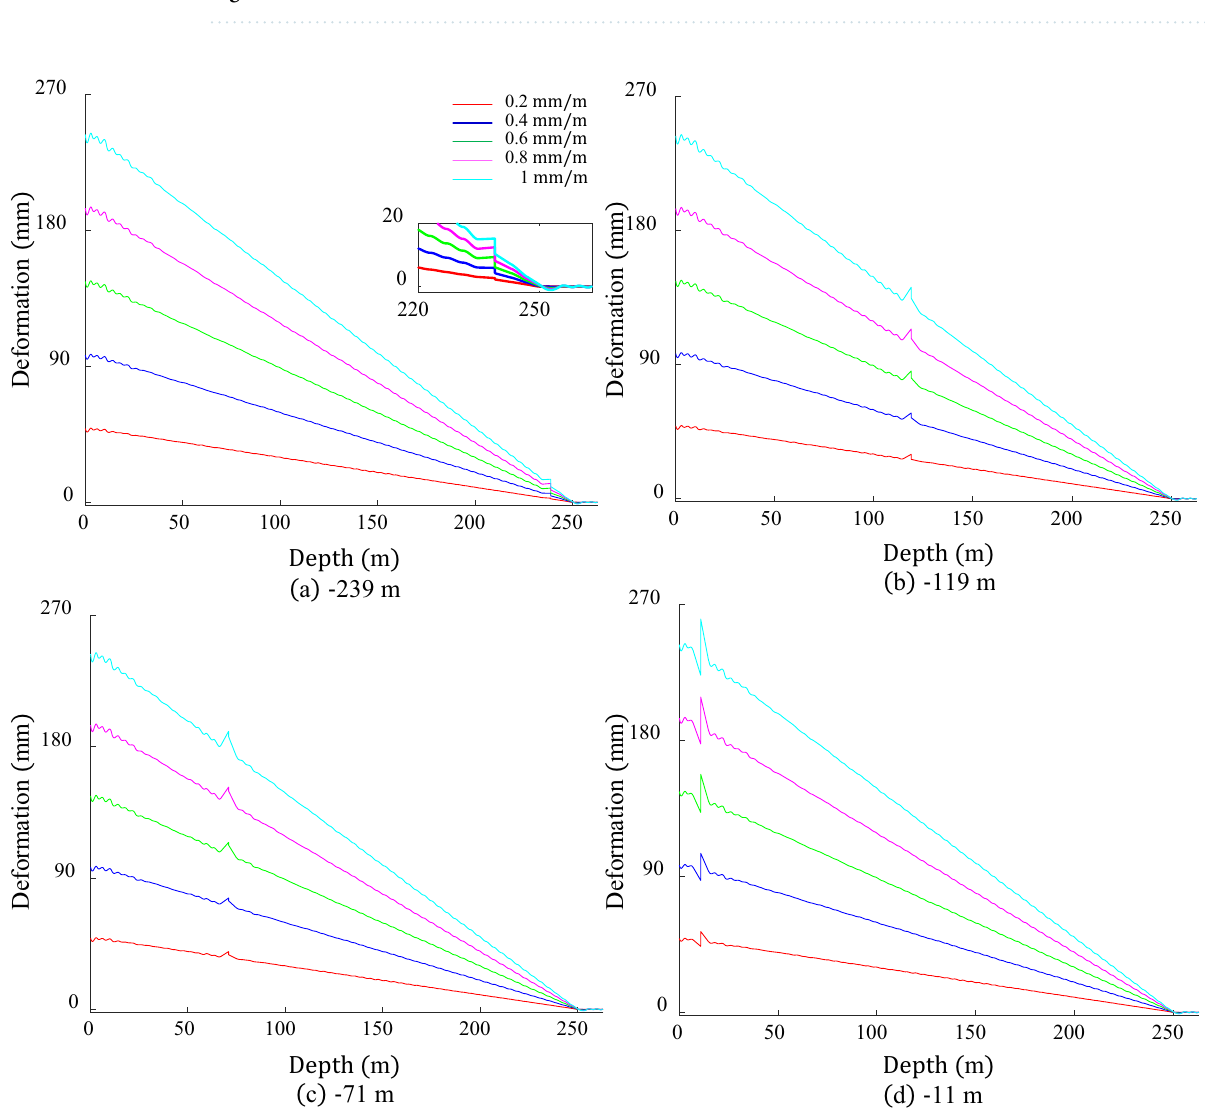
Figure 9. GRD in x -direction under inclination.